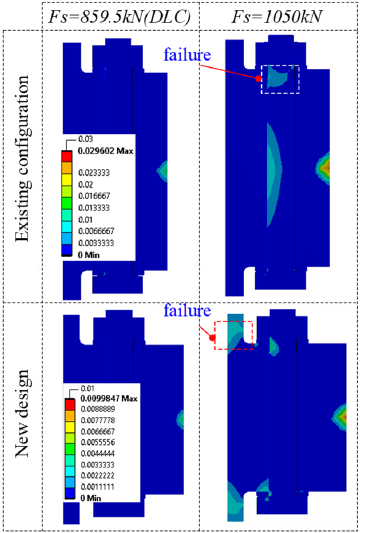
(cid:3046) (cid:3404) 050 kN.